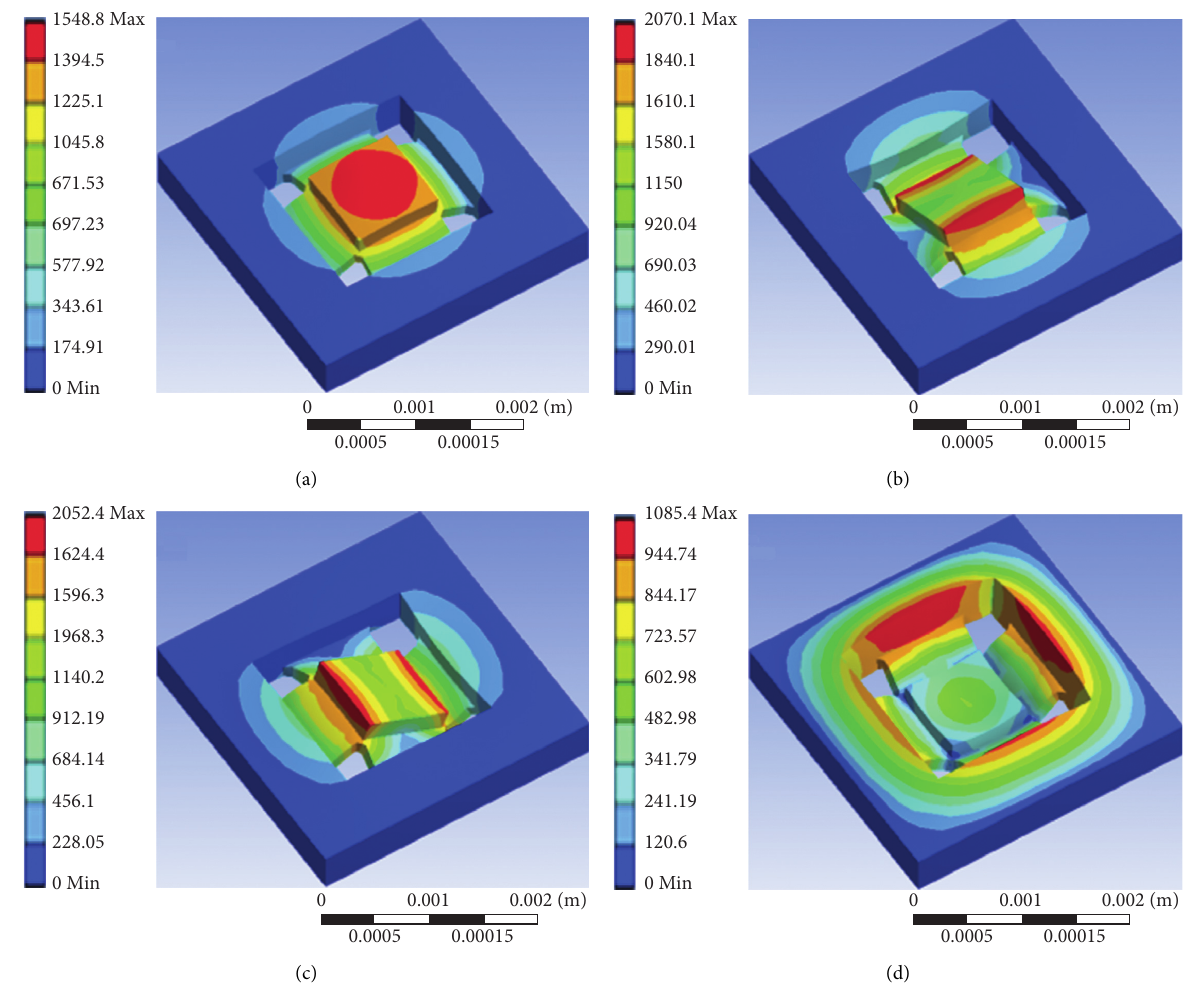
Figure 4: Simulation analysis of the four resonant modes of the accelerometer. Table 2: The frequencies of the accelerometer’s resonant modes. Resonant